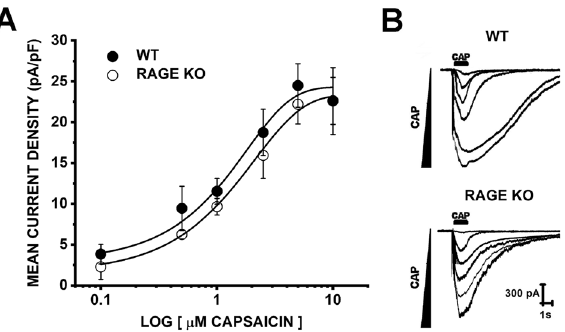
Figure 1. Dose–response of CAP-evoked currents in wild-type and RAGE KO tDRG neurons. Concentration dependency of CAP-evoked currents from cultured tDRG neurons from wild-type (WT) and RAGE-knockout (RAGE KO) mice by whole-cell patch clamp electrophysiology. DRGs neurons were clamped at -60 mV and exposed to CAP for 1 s. Data points indicate mean current density (pA/pF) at 0.1 (WT n = 10; RAGE KO n = 10), 0.5 (WT n = 7; RAGE KO n = 8), 1 (WT n = 16; RAGE KO n = 16), 2.5 (WT n = 6; RAGE KO n = 7), 5 (WT n = 9; RAGE KO n = 8) and 10 µM CAP (WT n = 5; RAGE KO n = 9). The data were fitted with a logistic Hill function—WT r 2 = 0.98079; RAGE KO r 2 = 0.99648. Error bars indicate mean ± SEM. The EC 50 of CAP in wild- type and RAGE KO was 1.50 ± 1.29 µM and 2.01 ± 1.04 µM, respectively. Both EC 50 values were not significantly different according to unpaired t -test (Welch